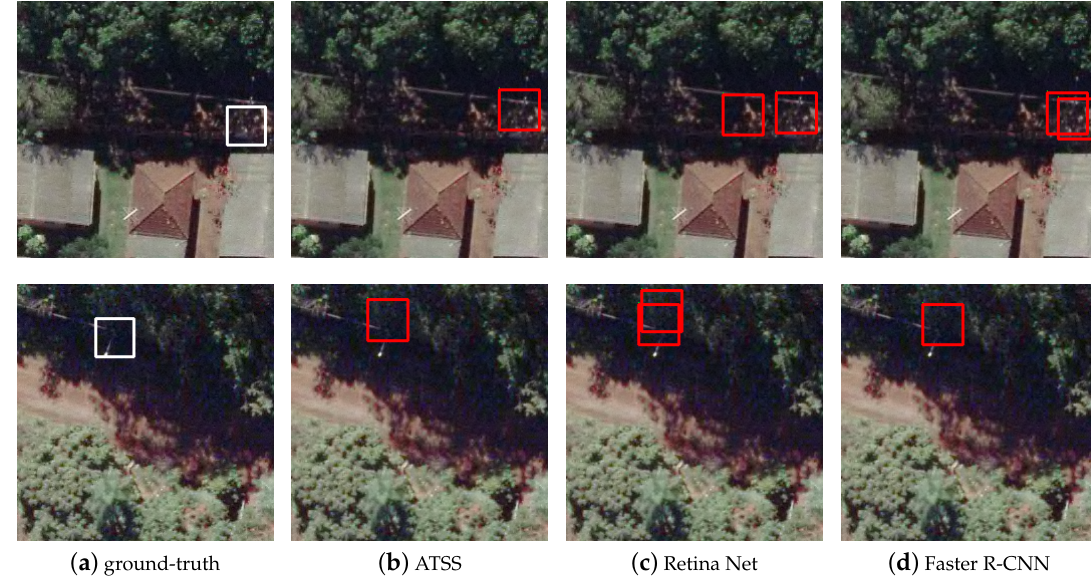
Figure 6. Examples of images with shaded poles: ( a ) ground-truth; ( b ) ATSS; ( c ) RetinaNet; and ( d ) Faster R-CNN.